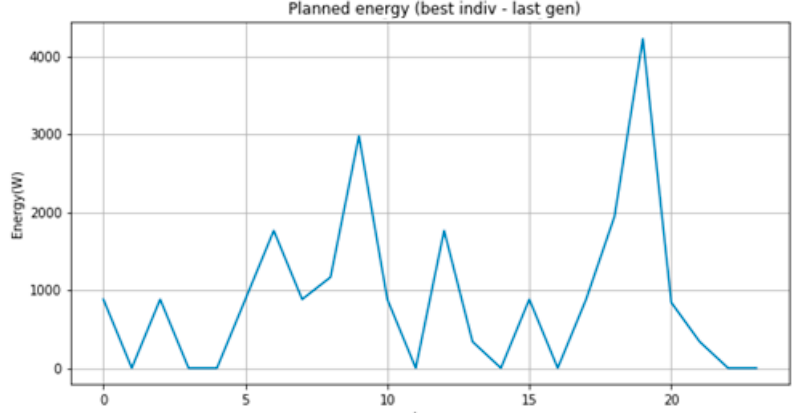
Figure 9. The individual from the 100th generation obtained using the genetic algorithm (GA), in which the planned distribution resulted in the lowest cost for profile generated by the simulator and is illustrated in Figure 7.